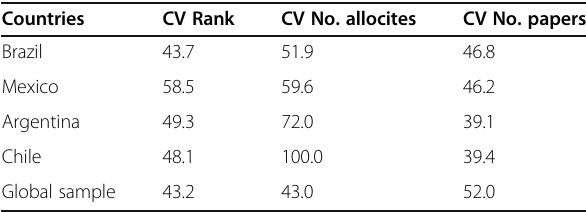
Table 2 Ranges of scientometric indicators, with regard to position in the Whole trajectory (Career-long) impact ranking, No. allocites, and No. papers in the Scopus database, for the most scientifically productive countries in Latin America (from Table-S6, Career-long ranking, by Ioannidis et al. [3]) Countries Career-long Rank No. papers